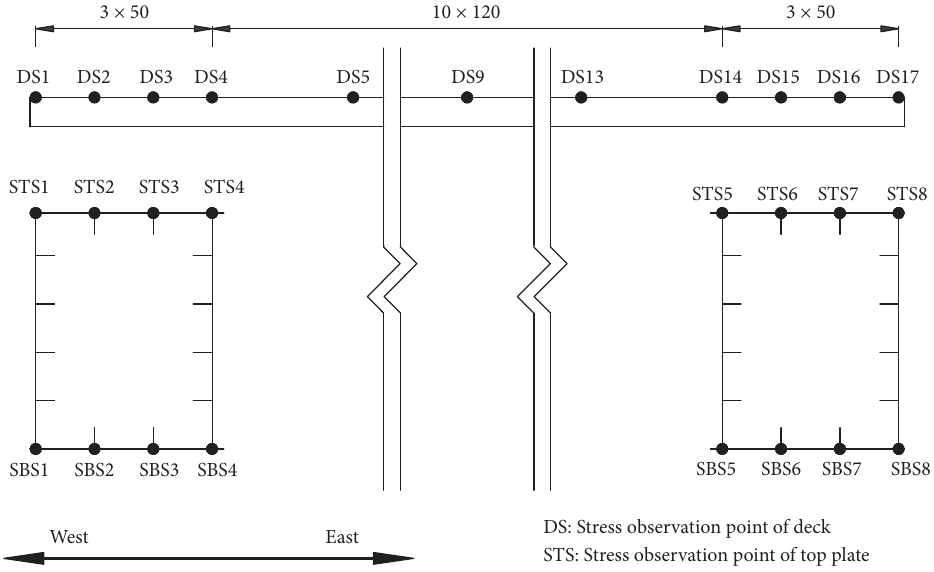
Figure 13: The location of stress observation points.